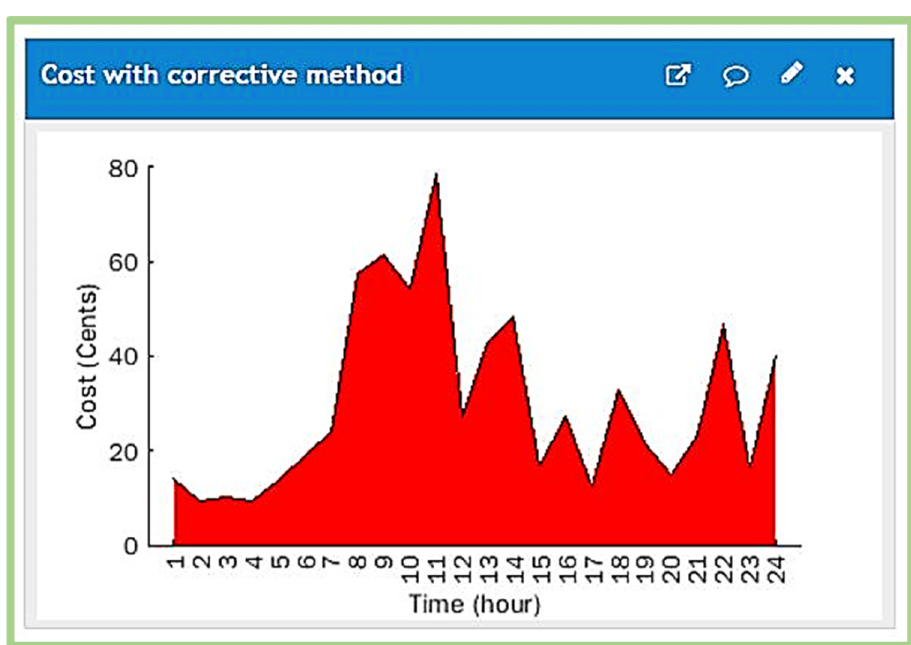
Figure 13. Cost GUI of suggested EMS with the corrective method.